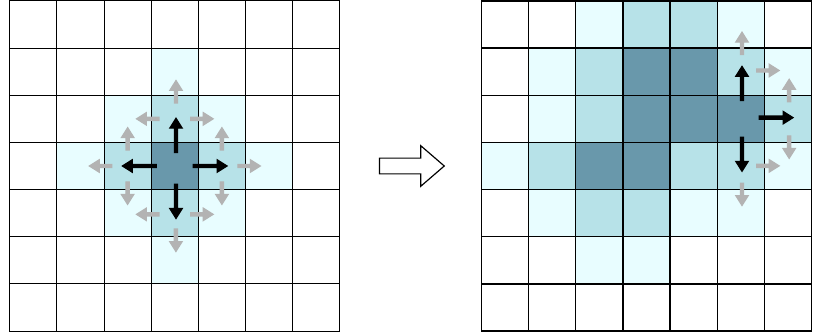
Figure 13. Region-growing labeling based on four neighbours